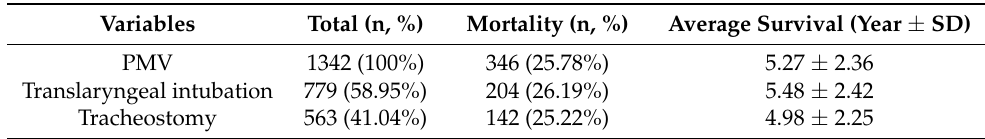
Table 2. Descriptive analysis of survival in patients with tracheostomy and translaryngeal intubation ( n =